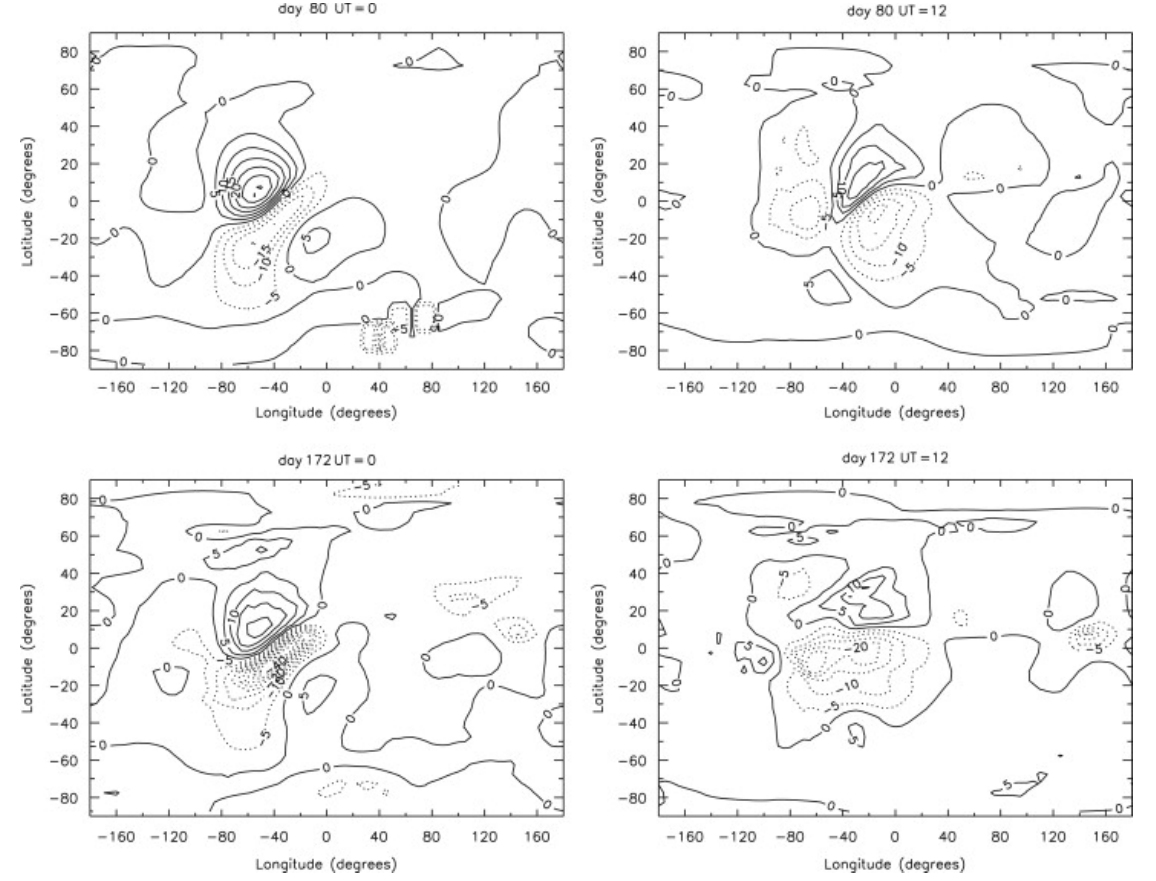
Figure 5. Global change in hmF2 (km) at day 80 ( top ) and day 172 ( bottom ) at 0 UT ( left ) and 12 UT ( right ) between 1997 and 1957 (1997–1957). (Reproduced from Cnossen and Richmond [38]: Figure 5).